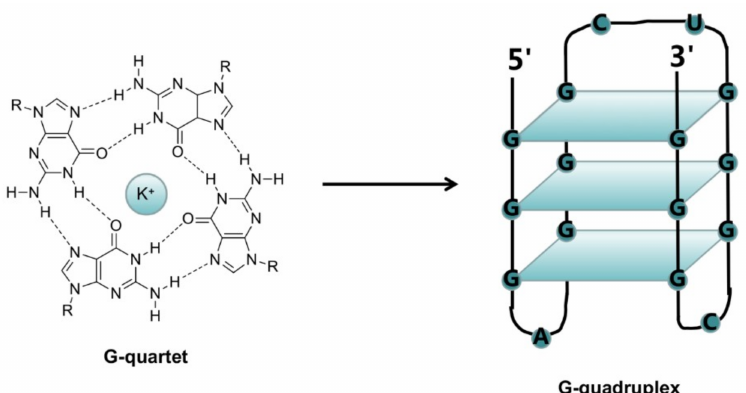
Figure 1. The structure of the G-quadruplex. Four guanines construct a G-quartet via Hoogsteen hydrogen bonds. Two or three G-quartets stack to form a G-quadruplex structure. Univalent metal cations (Na + or K + ) locate in the central channel of the G-quartet to stabilize the structure.